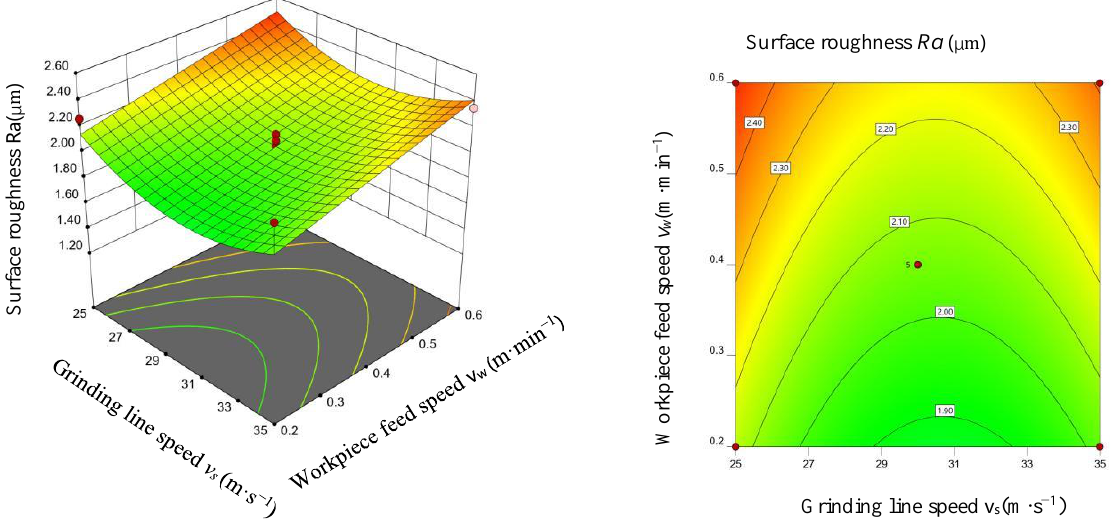
Figure 8. Grinding line speed–workpiece feed speed response surface and contour map.